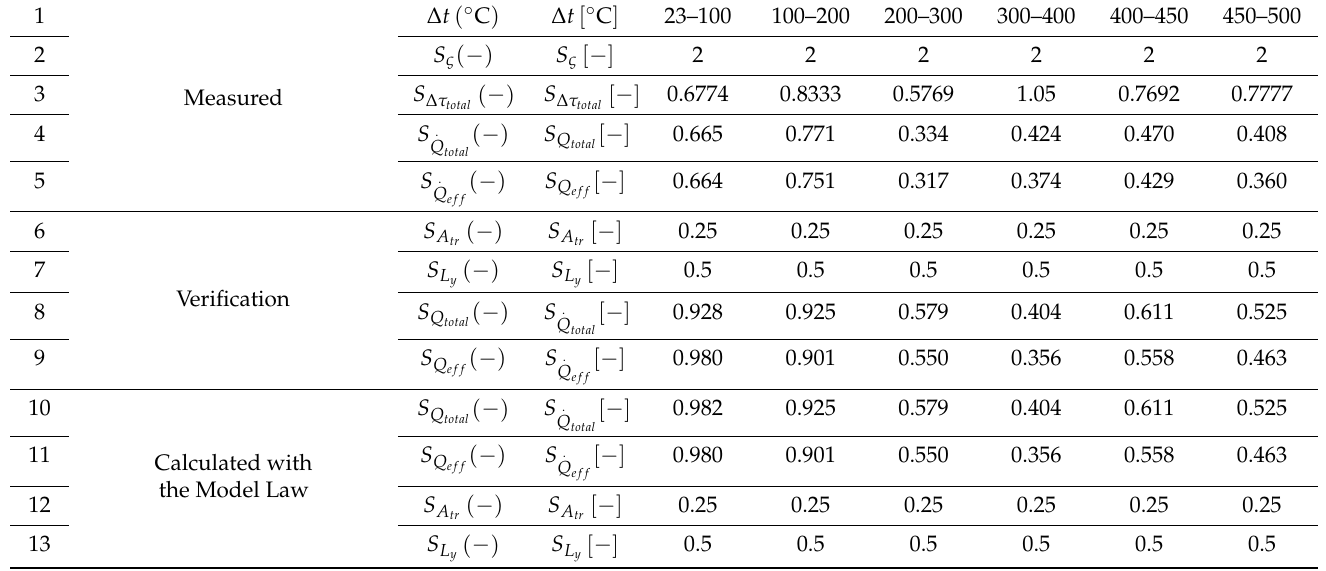
Table 5. The 1:2/1:1 unpainted model/prototype; measured values.